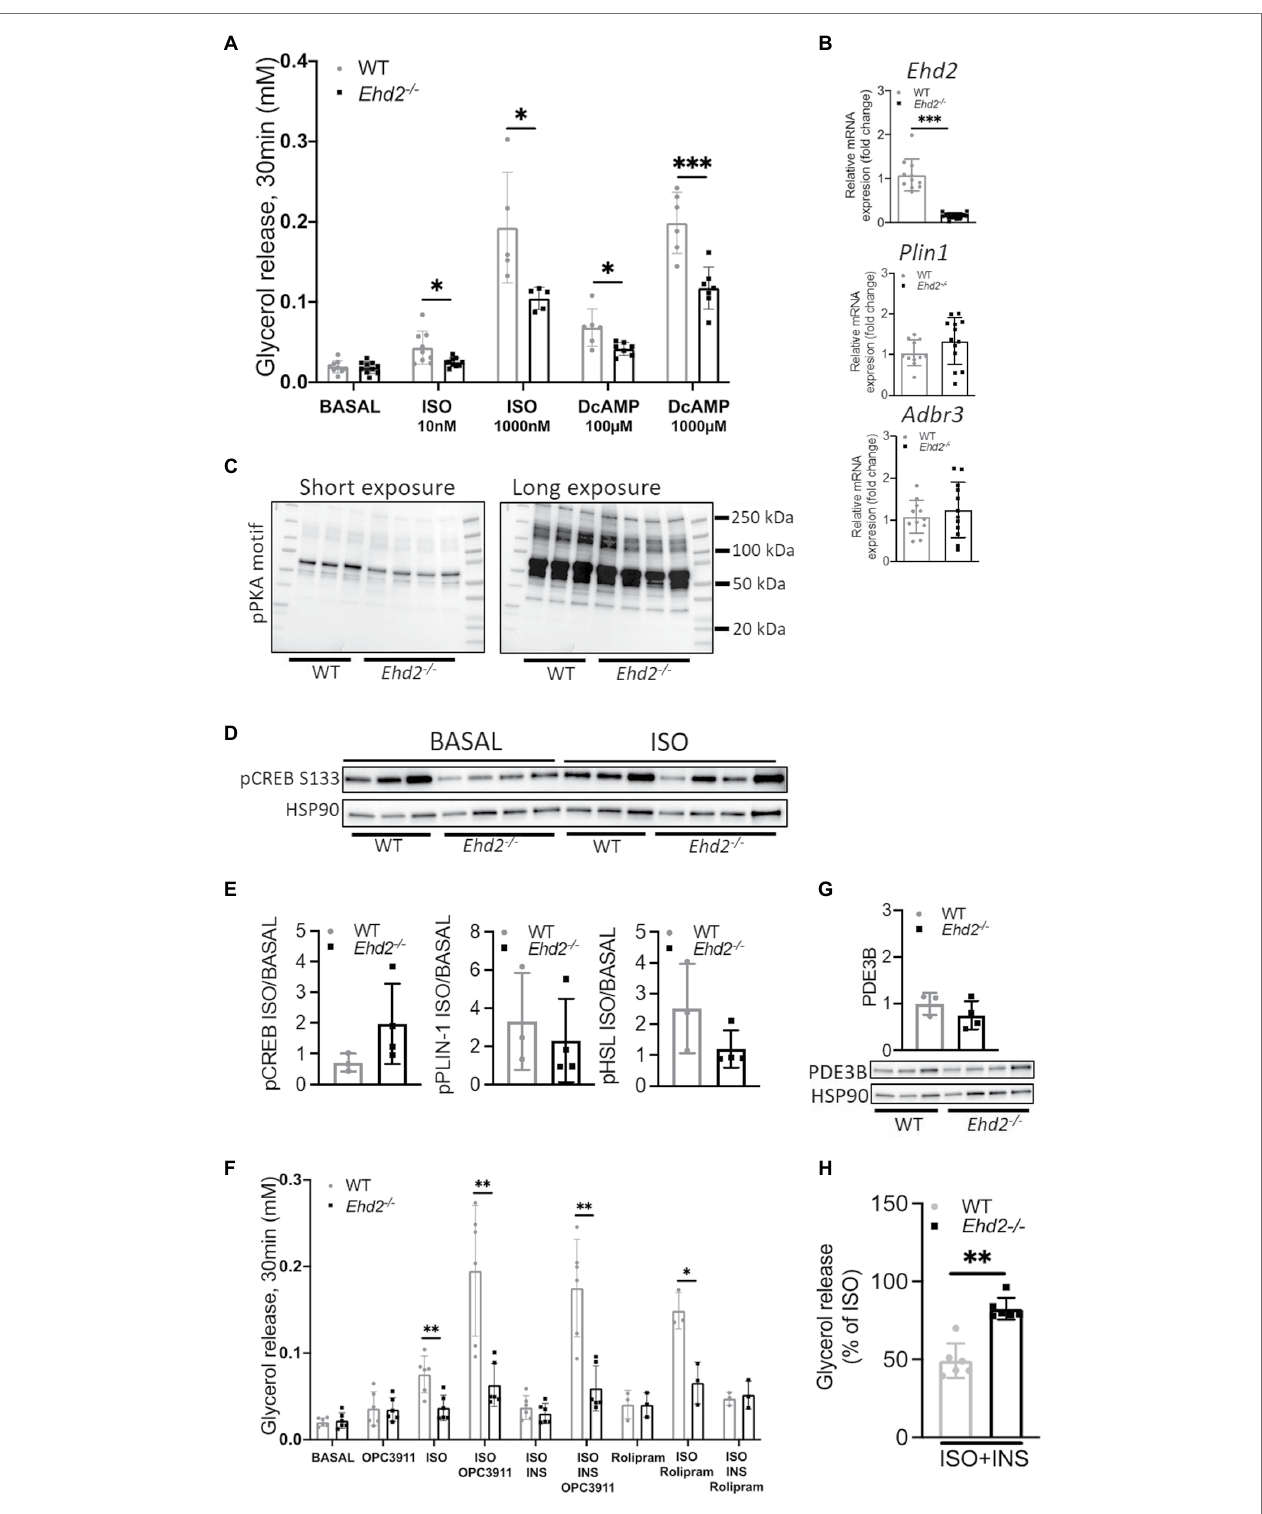
FIGURE 6 | Lipolysis using cAMP analog and PDE-inhibitors in inguinal adipocytes from Ehd2 − / − and WT mice. (A) Lipolysis measured as release of glycerol into the medium in a 10% (v/v) cell suspension using primary adipocytes isolated from the ING adipose tissue depot of HFD-fed mice. Cells in suspension were either non-stimulated (basal), or β adrenergic stimulated using isoprenalin (ISO; 10 or 1,000 nM), or stimulated with the non-degradable cAMP analogue dibutyryl